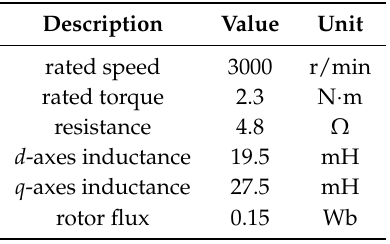
Table 1. Parameters of